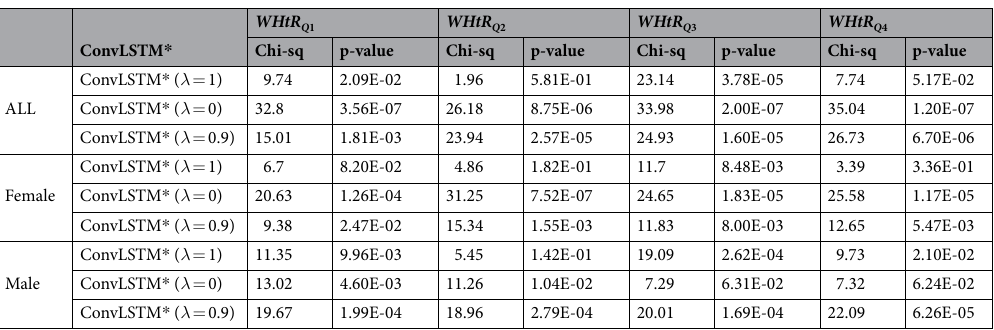
Table 8. Log rank results applying normalized biological age acceleration η = − ( ) CA BA quartiles. Results are shown for model with all subjects, and for separate models for females and males. Q1, Q2, etc. denote 1st quartile, 2nd quartile,